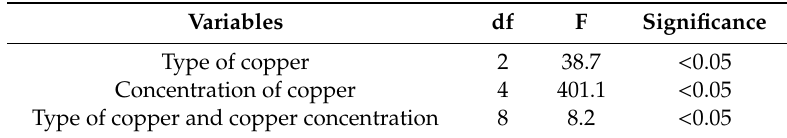
Figure 1. Effects of copper forms (Cu-NPs, CuO-NPs, CuO) at various concentrations of 0 (CT), 50, 100, 200, 500, and 1000 mg/mL on C. gloeosp. hyphal diameter growth. C. gloeosp. was grown in PDA for seven days at 25 °C. ( A ) Pathogen colony diameter in presence of tested copper forms; ( B ) Percent growth inhibition of pathogen hyphae by copper treatments at different concentrations. Table 1. Effects of copper forms, copper concentrations, and the interactions between both factors on the fungal hyphal growth (Analysis of Variance test).